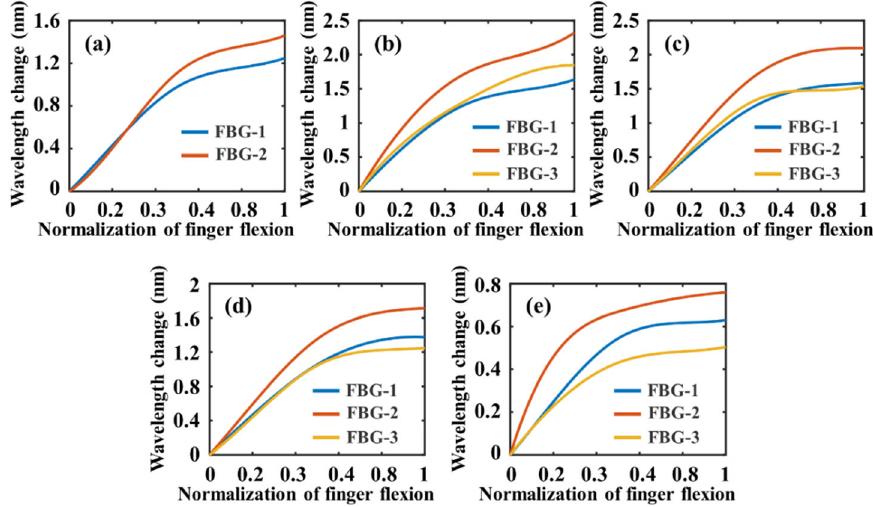
Figure 8. Results of interpolating the reflection peaks of the FBGs using cubic spline interpolation. ( a ) Interpolating of the thumb; ( b ) Interpolating of the index finger; ( c ) Interpolating of the middle finger; ( d ) Interpolating of the fourth finger; and ( e ) Interpolating of the little finger.